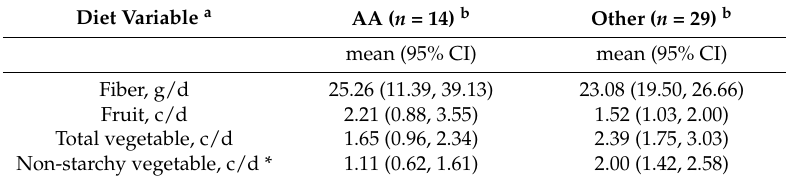
Table 2. Comparison of dietary intakes in African Americans versus other